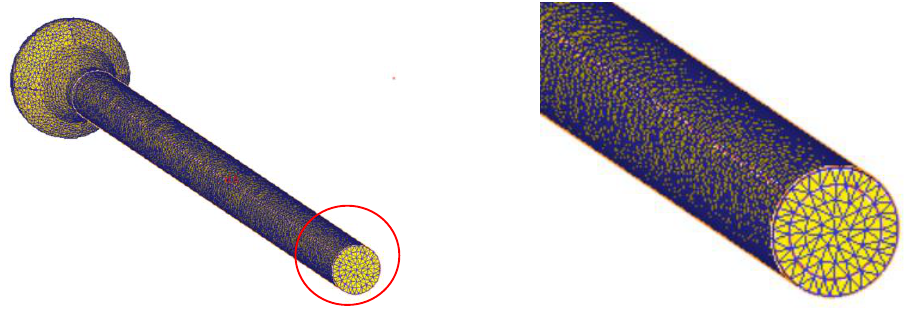
Figure 8. Refined grid around workpiece.